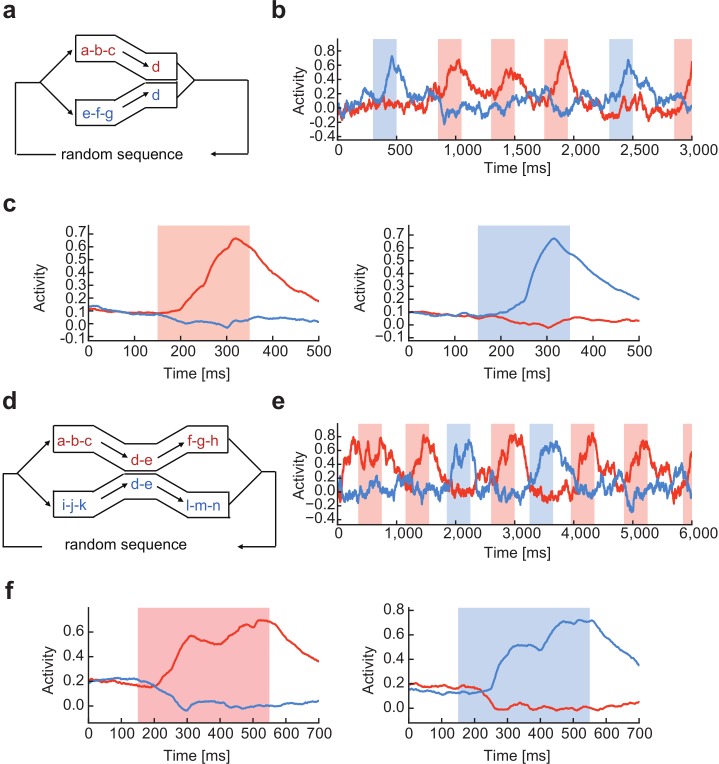
Learning chunks with mutual overlaps.(a) Two chunks shared the last component “d” in a random input sequence. (b) Activities of two readout units were selective to different chunks after learning. (c) The average response profiles are shown for the two readout units. (d) Two chunks shared the middle components “d-e” in a random input sequence. (e) and (f), Activities of two readout units and the average response profiles are shown, respectively.